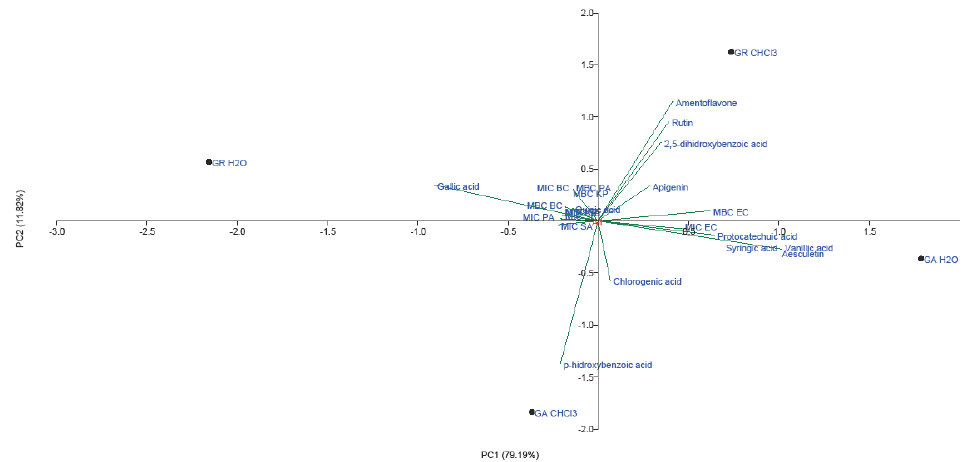
Figure 3. Figure 3. PCA of quantified phenolic compounds and AB activity of CHCl 3 and H 2 O extracts of G. applanatum and G. resinaceum . Abbreviations: GA— G. applanatum ; GR— G. resinaceu m: MBC— minimal bactericidal concentration (mg/mL); MIC—minimal inhibitory concentration (mg/mL); BC— B. cereus ; EC— E. coli ; KP— K. pneumoniae ; PA— P. aeruginosa ; SA— S. aureus . Flavonoids, including amentoflavone, rutin and apigenin, had the greatest loading in